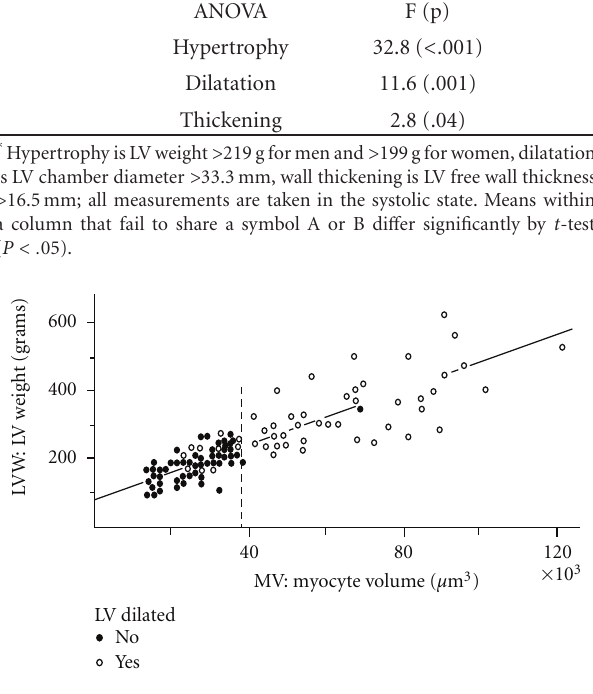
Figure 5: The sloping line plots (5) ( r = 0 . 86). Vertical dashed line plots (7), optimally separating circles from